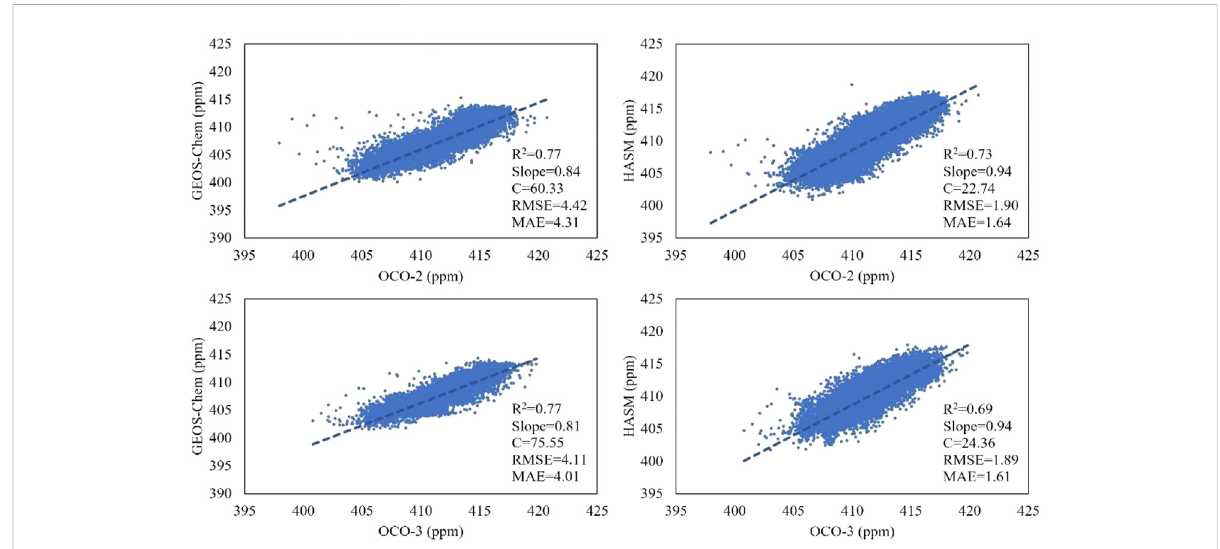
Comparison between XCO 2 concentrations from GEOS-Chem/HASM and observations from OCO-2/OCO-3. The coef fi cient of determination ( R 2 ), slope (S), constant (C), root mean square error (RMSE)and mean absolute error (MAE) of the linear regression are indicated in the lower right of the panel.